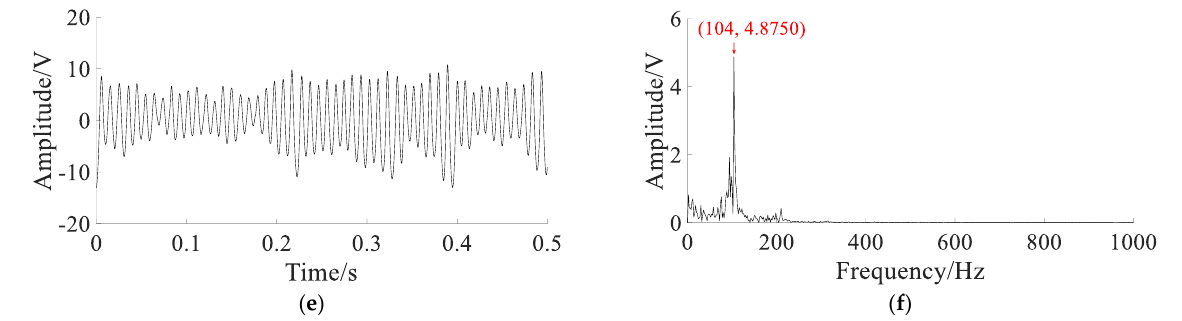
Figure 14. The results of different methods: ( a ) Hilbert transform envelope demodulation signal; ( b ) Hilbert envelope spectrum; ( c ) output signal of SGST adaptive SR: a = 0.0245, b = 0.0011, m = 3000, γ = 0.6828; ( d ) output signal spectrum of SGST adaptive SR; ( e ) output signal of SAFRM adaptive SR: R = 3000, γ = 0.0118, ε = 0.2515; ( f ) output signal spectrum of SAFRM adaptive SR.